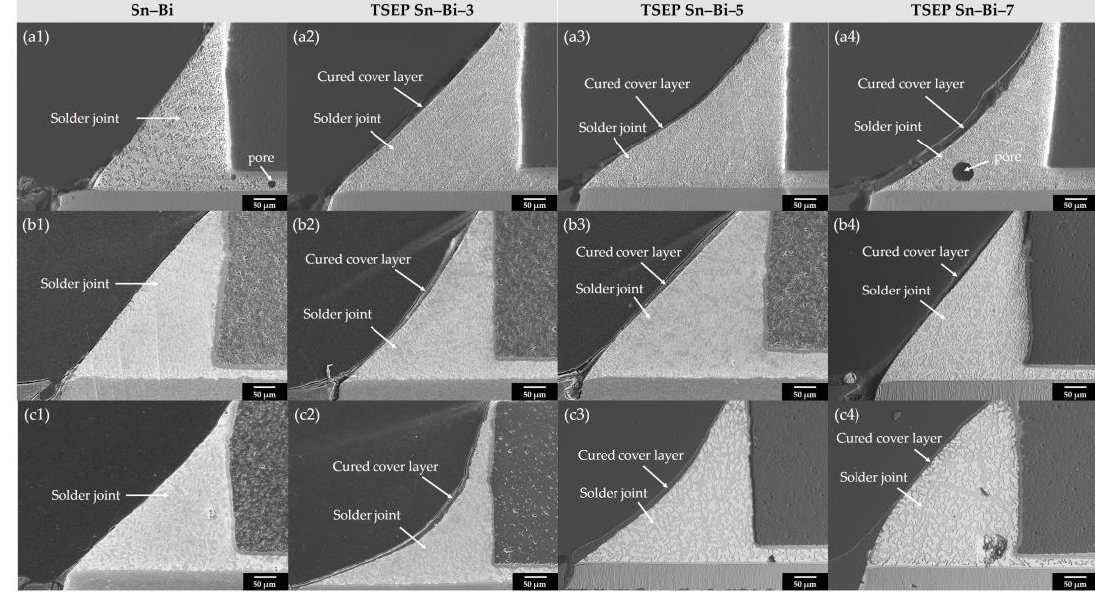
Figure 5. The Sn – Bi/Cu solder joints and TSEP Sn – Bi-x/Cu solder joints cross section after soldering: ( a1 – a4 ) Solder joints after soldering; ( b1 – b4 ) Solder joints after 1000 h; ( c1 – c4 ) Solder joints after 1000 cycles.